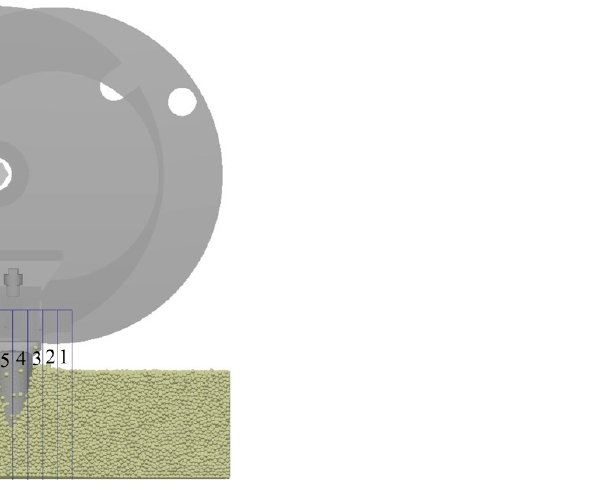
Figure 9. Diagram of the longitudinal monitoring area layout. Notes: 1–8 are various monitoring zones.